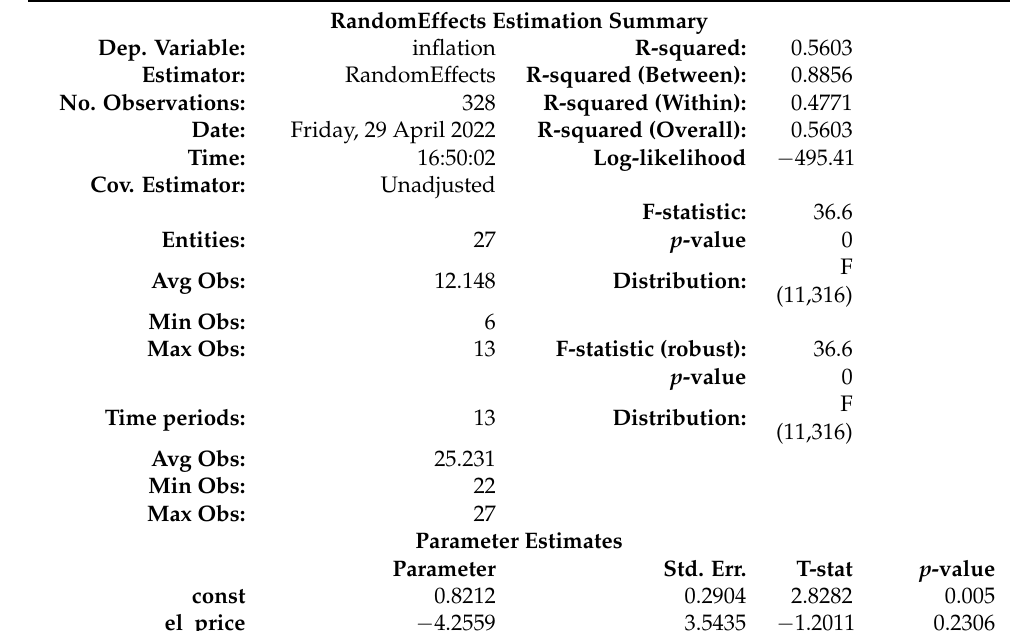
Table 6. The regression with the added share of renewable electricity, real GDP growth, nominal effective exchange rate, broad money change and their lags with past